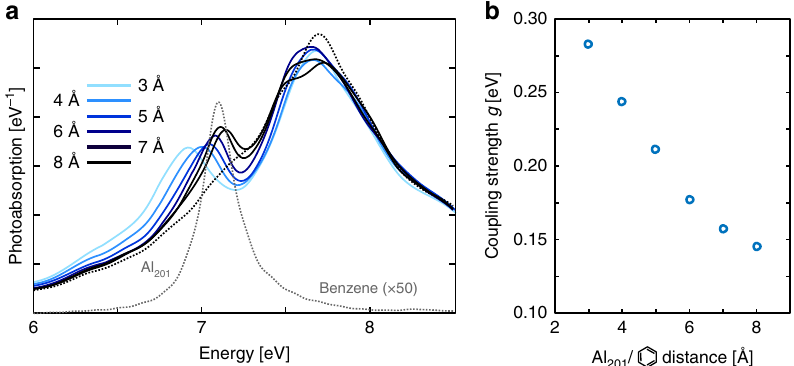
Fig. 5 Dependence of coupling on nanoparticle-molecule separation. a Photoabsorption spectra for two benzene molecules coupled to the Al 201 particle, showing weaker splitting with increasing separation from 3 – 8 Å. b Coupling strength for two benzene molecules as a function of distance from the Al 201 particle, showing the expected decrease due to the decreasing overlap integral between exciton and